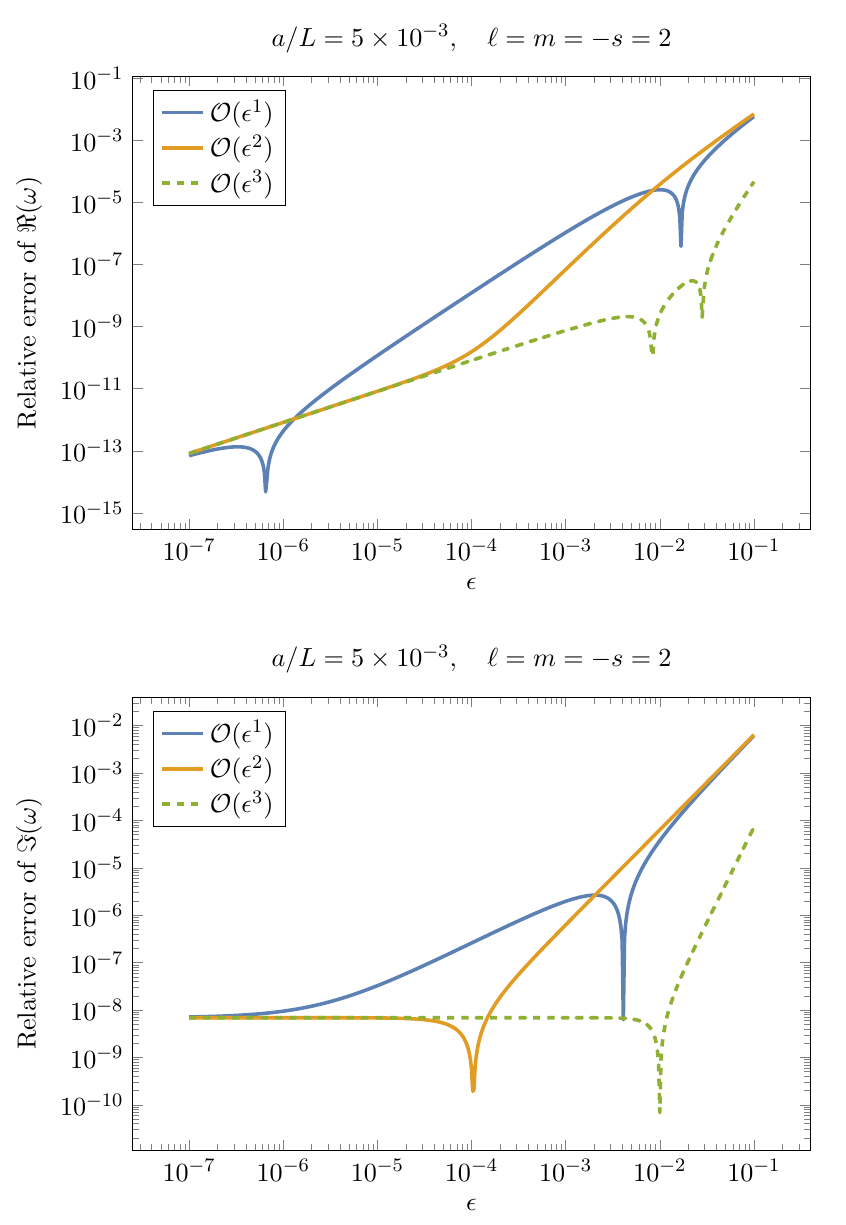
Figure 5 . Relative error in the QNM frequencies when comparing our analytic expansion in eq. (1.1) with a numerical calculation. It is plotted as a function of (cid:15) and for the mode s = ‘ = m = 2 and a = 5 10 (cid:0) 3 L . The top graph is for the real part of the QNM frequency and the (cid:1) bottom graph for the imaginary part. Within each plot, the curve which is at the top corresponds to the relative error with the analytic expansion truncated to O ( (cid:15) ). The subsequent two lower curves correspond to truncation at O ( (cid:15) 2 ) and O ( (cid:15) 3 ),